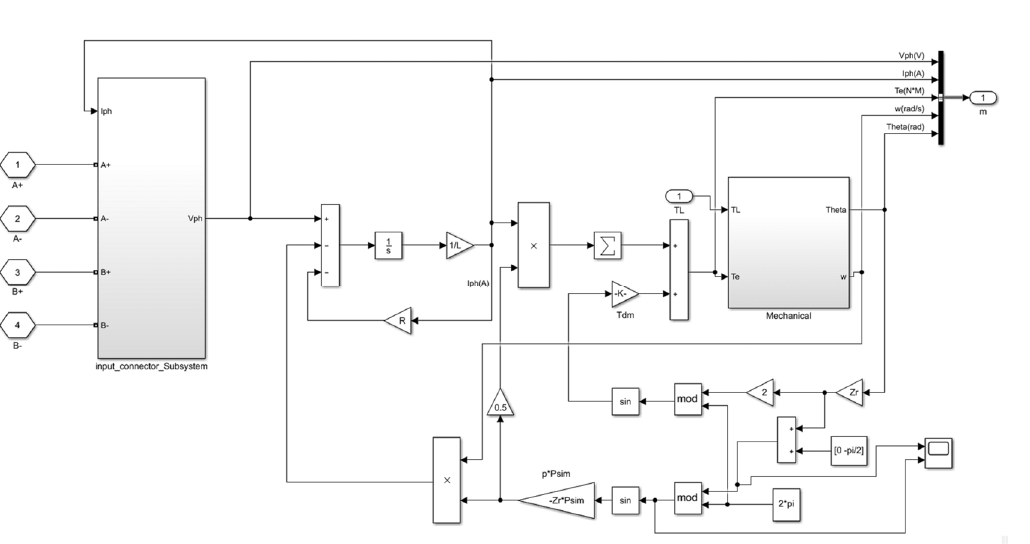
Figure 7. Position-based PID control schematic.